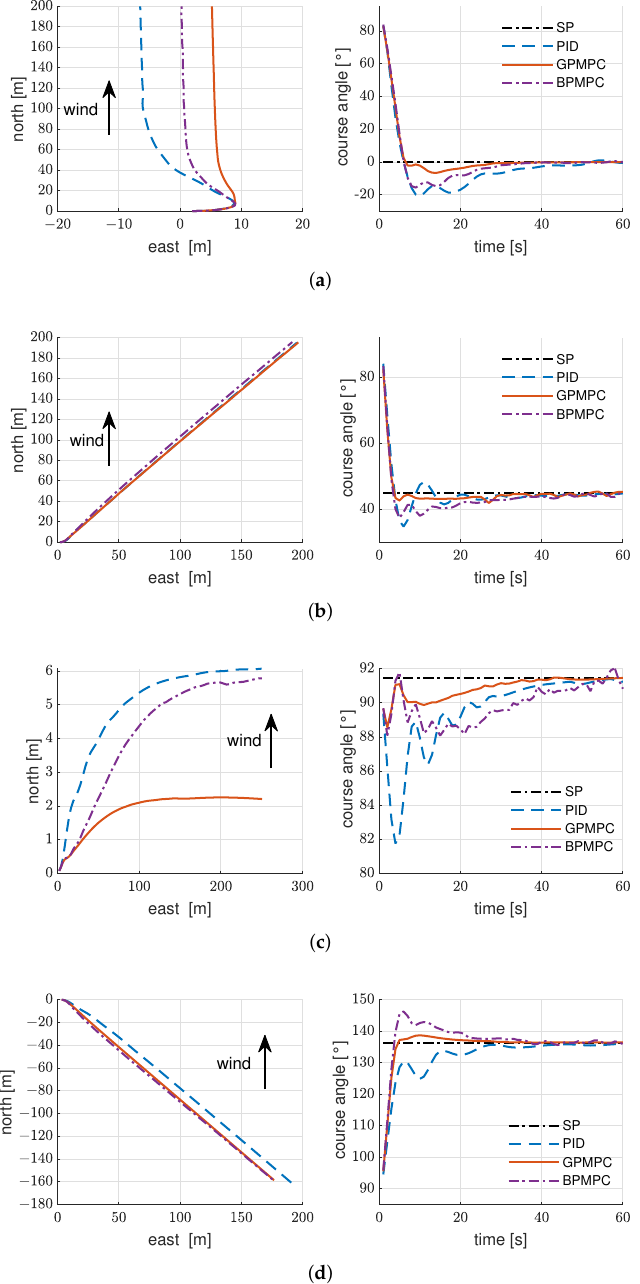
Figure 15. The sailing trajectory ( left ) and course angle curve ( right ) in different heading changes. The black dotted line is Set Point (SP), the blue dashed line is the PID control effect, the purple dotted line is the BPMPC control effect, and the orange solid line is the GPMPC control effect. ( a ) The course angle from 90 degrees to 0 degrees; ( b ) the course angle from 90 degrees to 45 degrees; ( c ) the course angle from 90 degrees to 90 + 1.5 degrees; and ( d ) the course angle from 90 degrees to 135